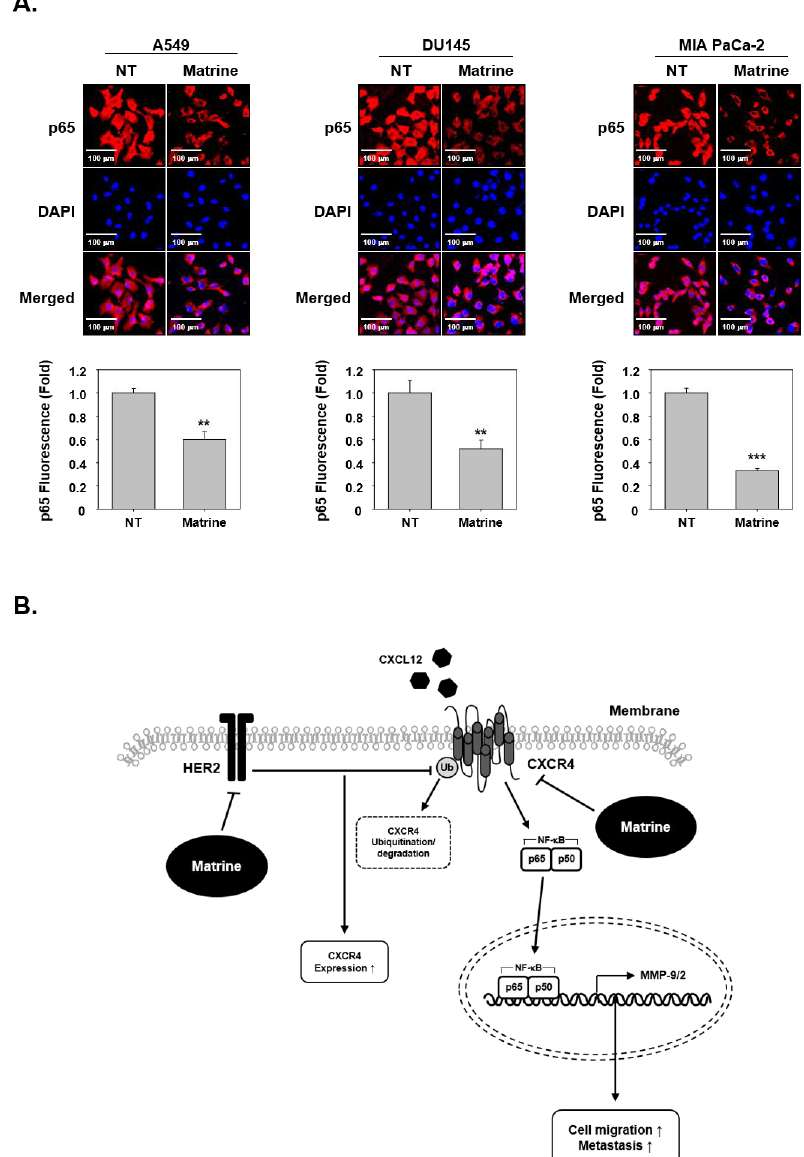
Figure 5. Matrine inhibits translocation of NF-κB into nucleus in A549, DU145, and MIA PaCa-2 cells. ( A ) p65 translocation into nucleus was observed by immunocytochemical analysis. A549, DU145, and MIA PaCa-2 cells (2 × 10 4 cells / well) were treated with matrine (50 µ M) for 24 h in 37 ◦ C, 5% CO 2 incubator. P65 was observed in red, nuclear was observed in blue color. Cells were analyzed by Olympus FluoView FV1000 confocal microscope (Tokyo, Japan). ( B ) A proposed model of the matrine effect on CXCR4 activation. All experiments were performed independently at least three times and representative data are shown. *** p < 0.001, ** p < 0.01 vs. non-treated (NT) cells.